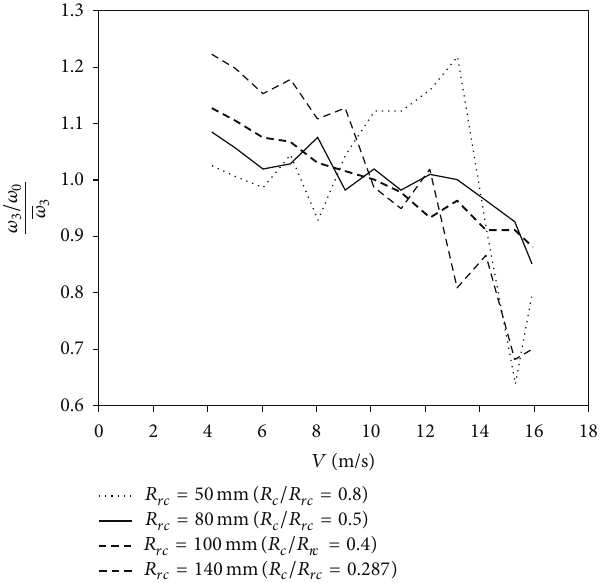
Figure 7: Variation of the third harmonic term measured with rotors equipped with 𝑅 𝑐 = 40 mm conical cups as a function of the wind speed within the calibration